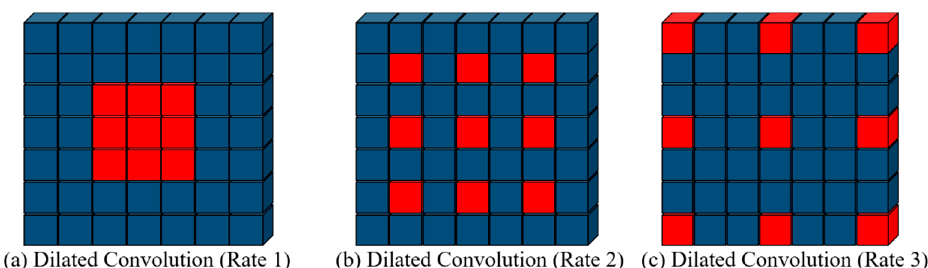
Figure 8. The mechanism of dilated convolution with different rates.